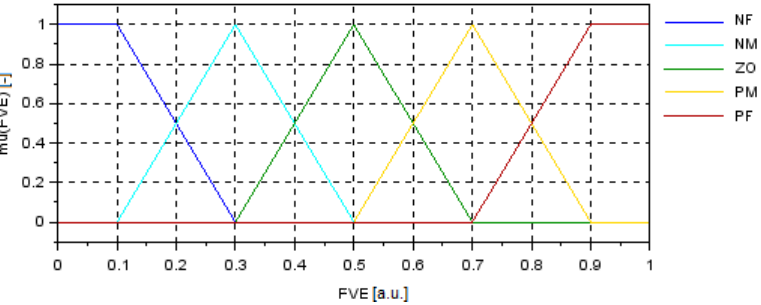
Figure 6. The fuzzy sets defined as: NF, NM, ZO, PM, PF, with specified membership functions of the L -, Λ - or Γ